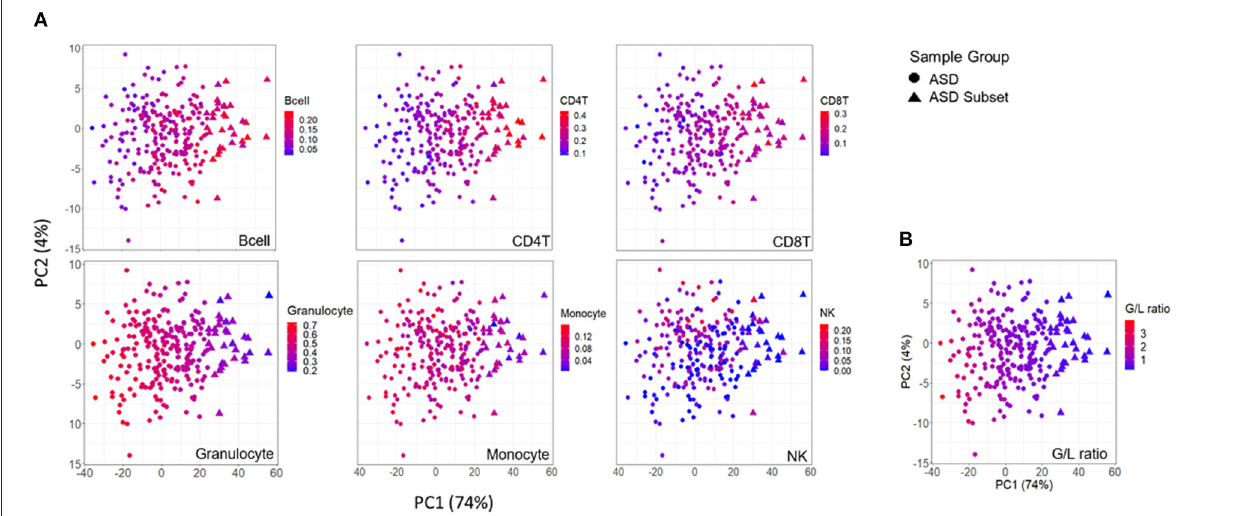
FIGURE 4 | Association between DNAm variation and cell type proportions across ASD cases. Scatterplots of first two principal components from principal component analysis (PCA) performed on 400 differentially methylated sites between ASD cases ( n = 265), and controls ( n = 122). (A) distribution of blood cell proportions [from left to right: B cells, CD4T cells, CD8T cells, granulocytes, monocytes and natural killer cells (NK)] and (B) granulocyte/lymphocyte (G/L) ratio across ASD cases. Samples plotted as triangles represent distinct ASD subset ( n = 32) and circles represent remaining ASD cases ( n = 233). Color of point indicates proportion of given cell type in each